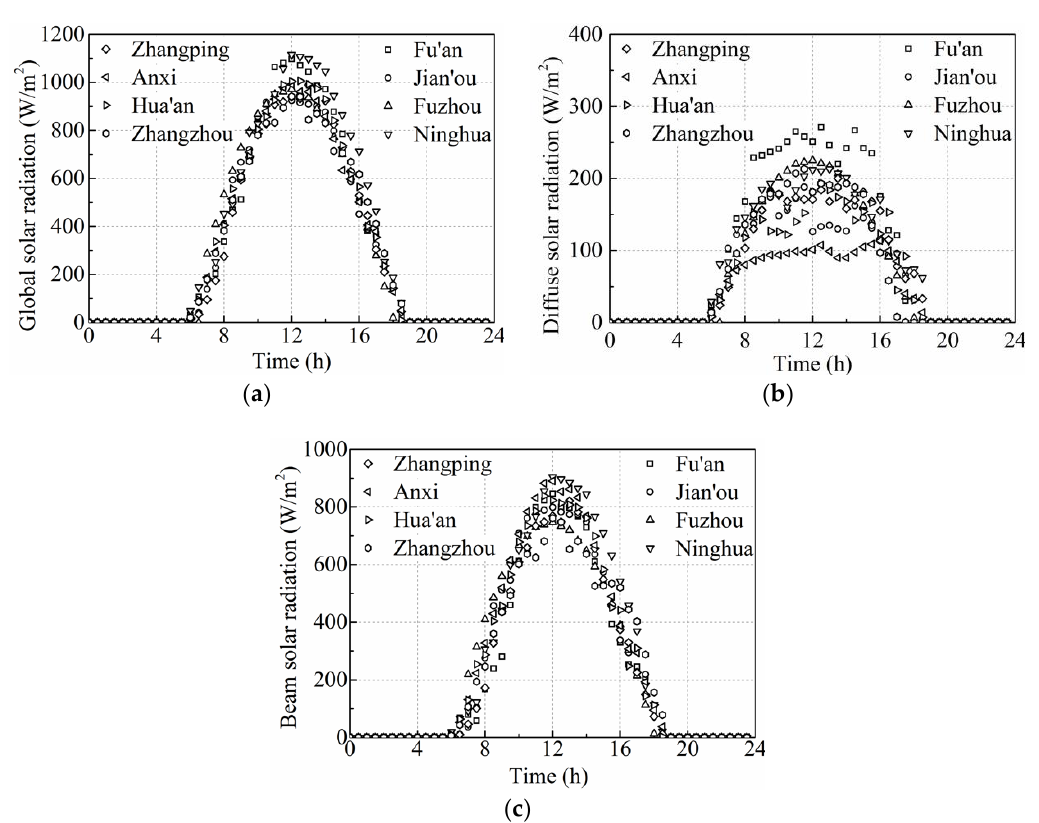
Figure 3. Hourly solar radiation: ( a ) measured global solar radiation; ( b ) measured diffuse solar radiation; and ( c ) calculated beam solar radiation.